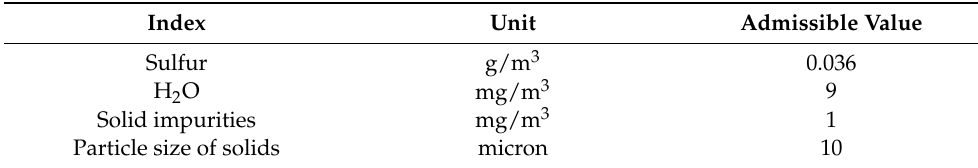
Table 1. The main criteria for the qualitative composition of CMM. The data in the table are given in accordance with the state standards of the Russian